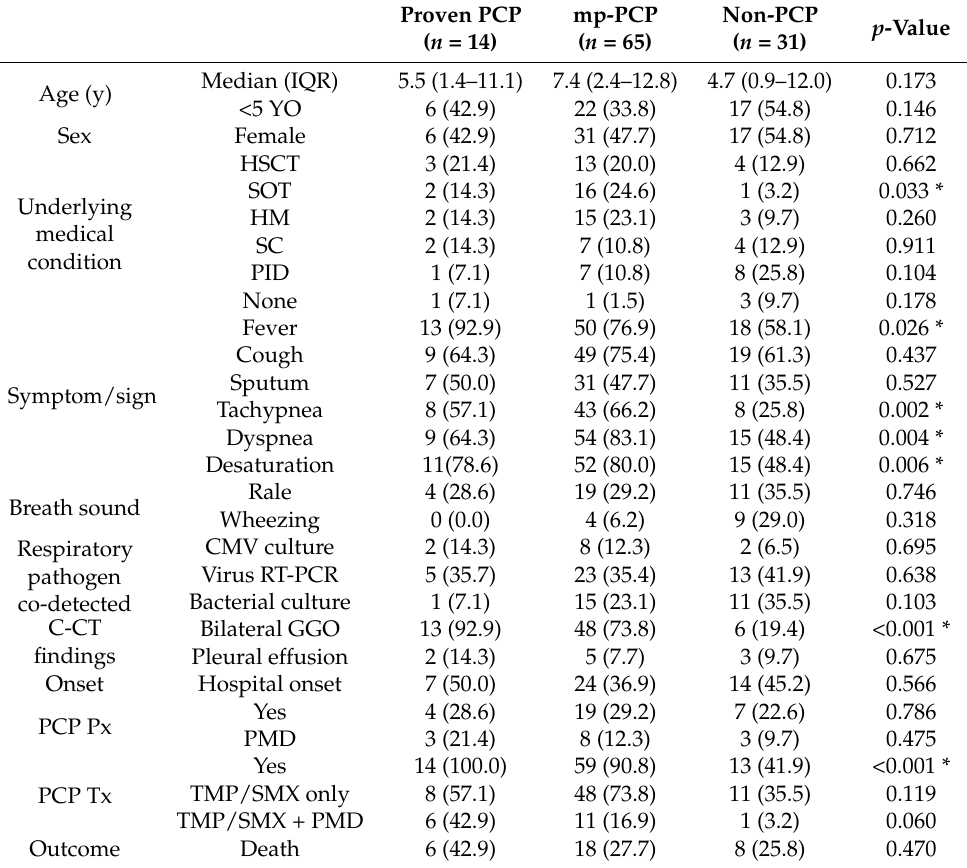
Table 1. Clinical characteristics of children with clinical PCP, n